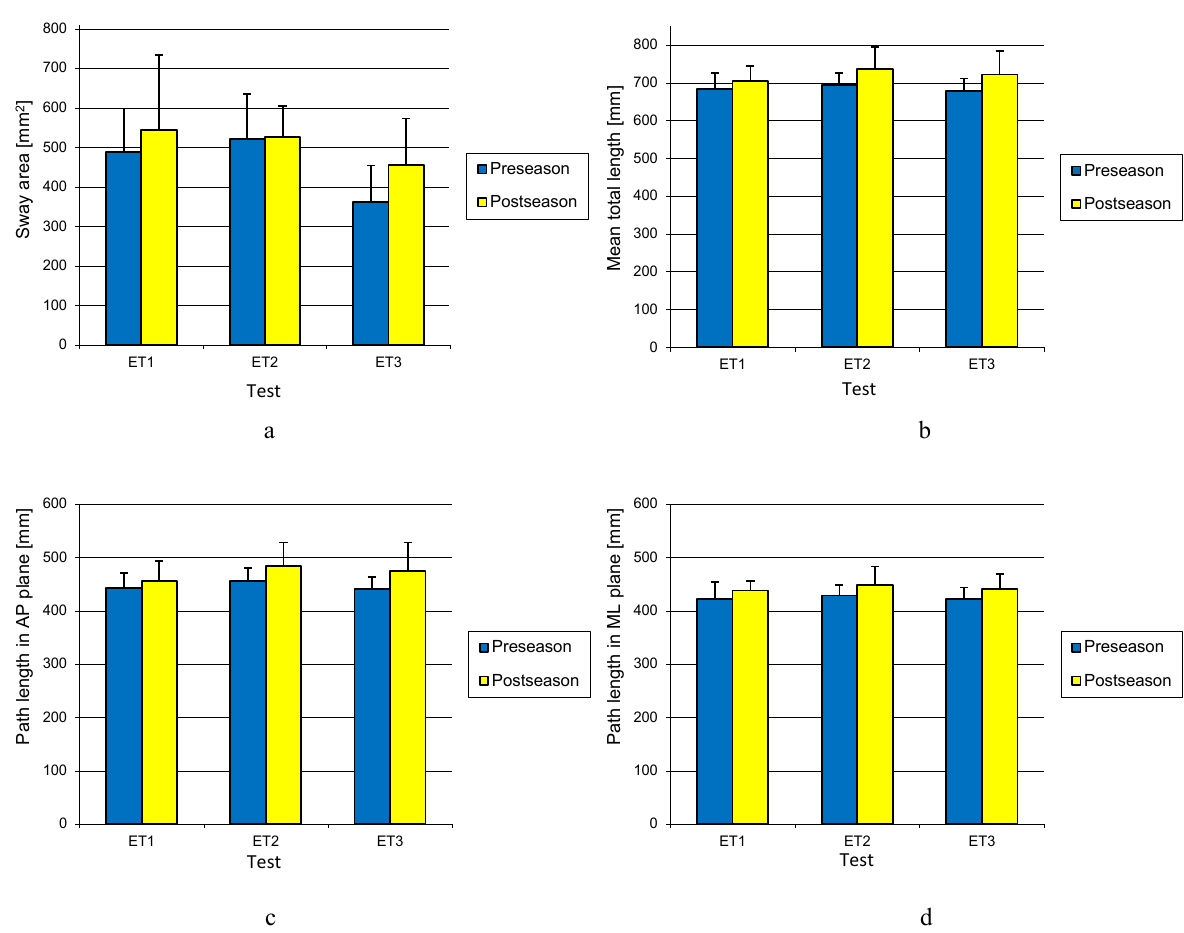
Figure 1. Group mean values (± S.D.) of sway area, total length of stabilogram, length of stabilogram in sagittal plane and length of stabilogram in frontal plane in pole vaulters in postseason and